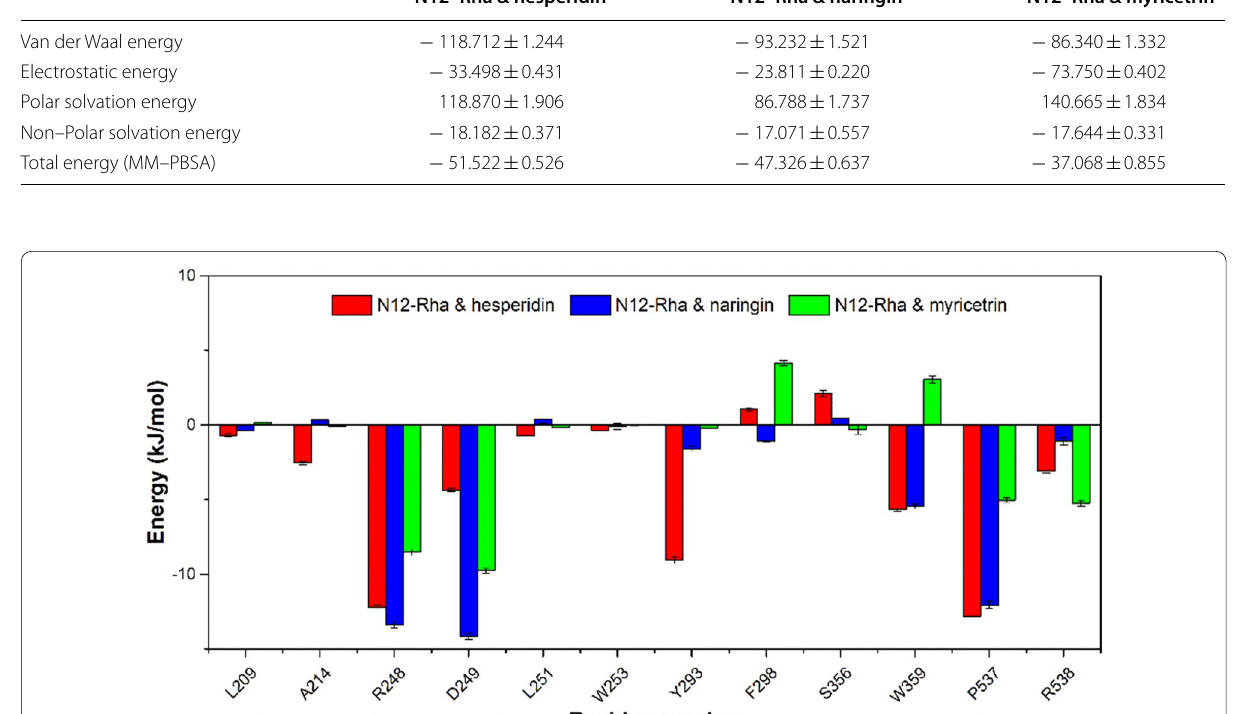
Fig. 7 Interaction energies of the hesperidin and naringin, myricetrin with N12-Rha ((α/α) 6 -barrel domain) based on MM-PBSA analysis during 15–20 ns MD